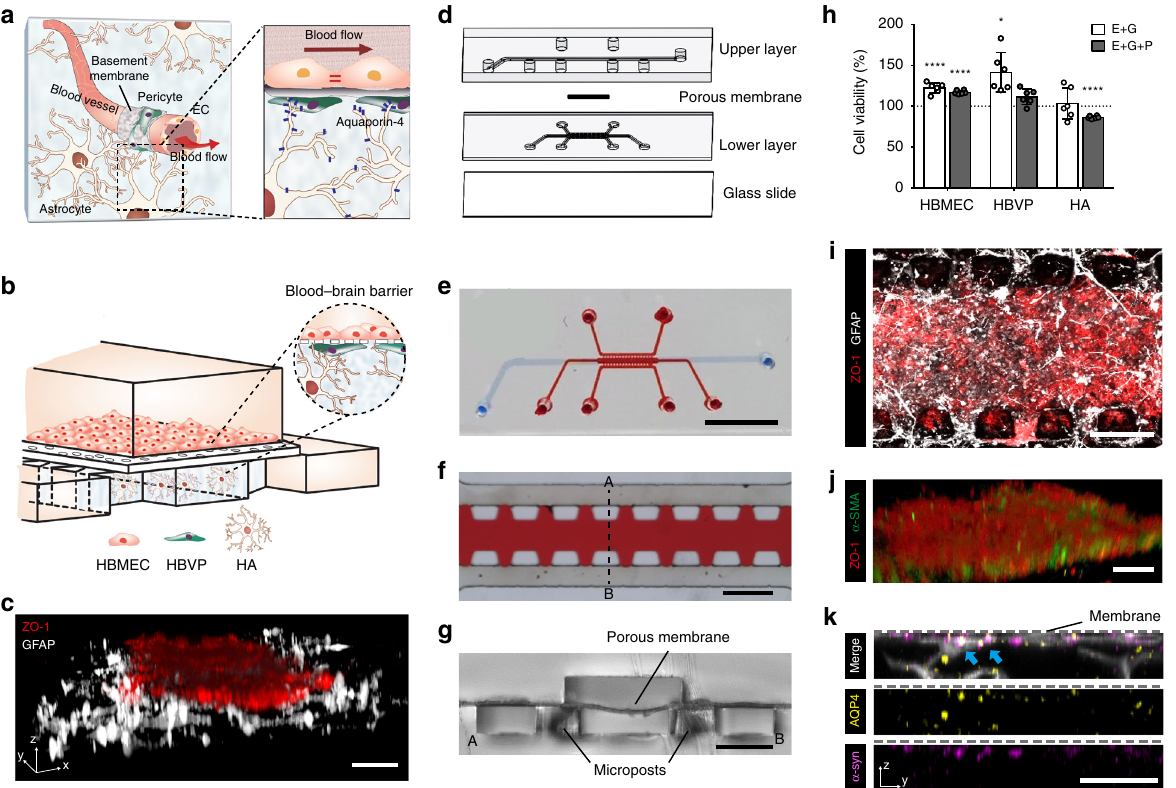
Fig. 1 Microengineered human blood – brain barrier (BBB) model. a Schematic description of the BBB consisting of endothelial cells (ECs) along the blood vessel under continuous blood fl ow, pericytes covering the endothelial monolayer, and astrocytes with aquaporin-4 (AQP4) expression at their end-feet near the blood vessel. b Schematic description of our microengineered human BBB model. c 3D con fi guration of the BBB model showing human brain microvascular endothelial cells (HBMECs) (ZO-1, red) and human astrocytes (HAs) (GFAP, white) (scale bar = 100 µ m). d Explosion view of the device consisting of upper vascular layer, porous membrane, lower perivascular layer, and glass slide. e A photo of the device after completing fabrication of the device (blue: upper channel and red: lower channels) (scale bar = 500 µ m). f Lower layer consisting of three parallel channels separated by series of micropillars (red: center channel) (scale bar = 500 µ m). g Cross-section of the device after fabrication (along A-B in Fig. 1f) (scale bar = 200 µ m). h Cell metabolic activities assessed by a (3-(4,5-dimethylthiazol-2-yl)-5-(3-carboxymethoxyphenyl)-2-(4-sulfophenyl)-2H-tetrazolium) (MTS) assay (E + G: 1:1:1 mixture of endothelial medium, astrocyte medium, and microglia medium, E + G + P: 1:1:1:1 mixture of endothelial medium, astrocyte medium, microglia medium, and pericyte medium) (Data represent mean ± s.d. of n = 6 for each condition, * p < 0.05 and **** p < 0.001 versus each cell culture medium by student t -test). i Bottom view of the device with endothelial monolayer (ZO-1, red) and astrocytic network (GFAP, white) (scale bar = 50 µ m). j Endothelial monolayer (ZO-1, red) supported by a layer of human brain vascular pericytes (HBVPs) ( α -SMA, green) (scale bar = 50 µ m). k Aquaporin-4 (AQP4, yellow) and α -syntrophin ( α -syn, magenta) expressions at astrocytic end-feet (GFAP, white) underneath a porous membrane (indicated as the dotted line) in the lower channel (Blue arrows indicate co-localization of AQP4 with α -syn.) (scale bar = 50 µ m). All images are representative ones from at least fi ve biological and three technical